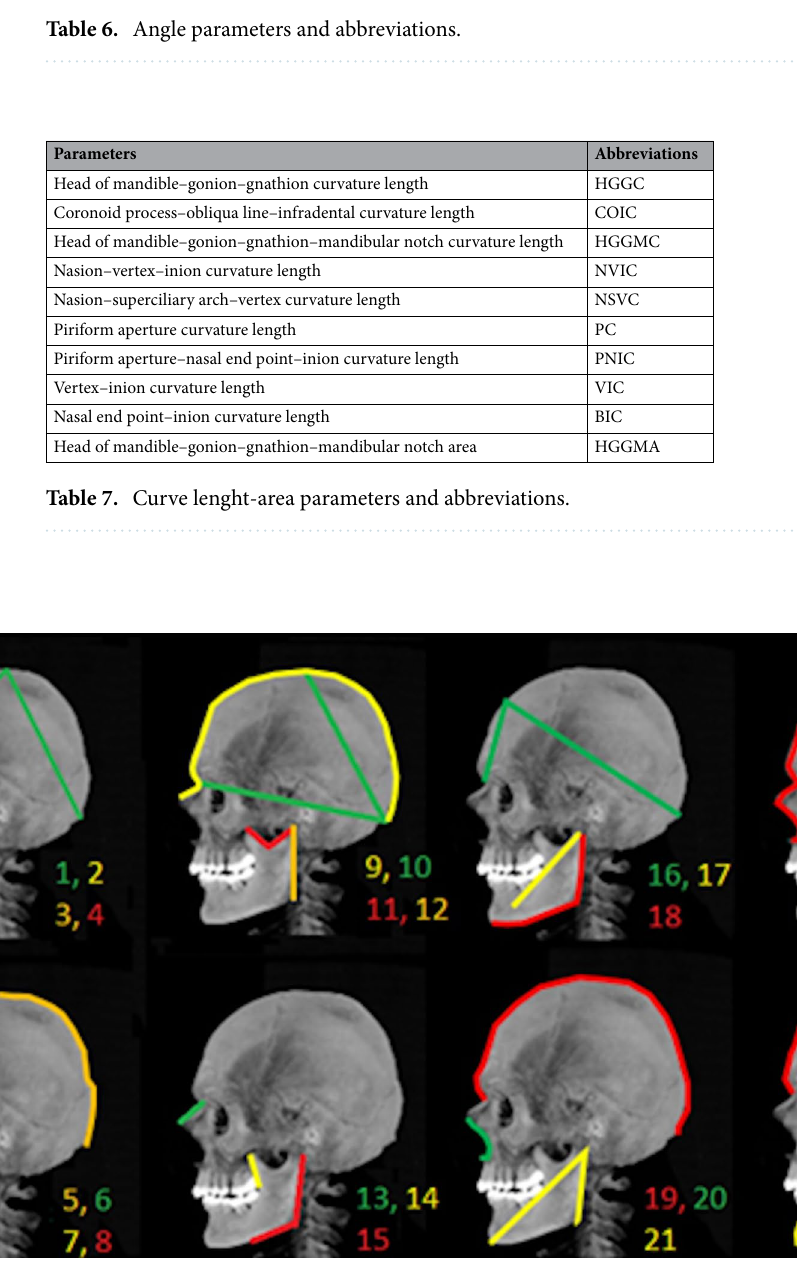
Figure 6. Demonstration of parameters (1: NVIA, 2: ZA, 3: COIC, 4: HGGA, 5: VIC, 6: NNZA, 7: COLI, 8: CML, 9: NIC, 10: NIVA, 11: CMHA, 12: RML, 13: NNL, 14: COL, 15: GA, 16: NFIA, 17: HML, 18: HGGC, 19: NVIC, 20: PC, 21: GCGA, 22: PNIC, 23: HGGMA, 24: NSVC, 25: